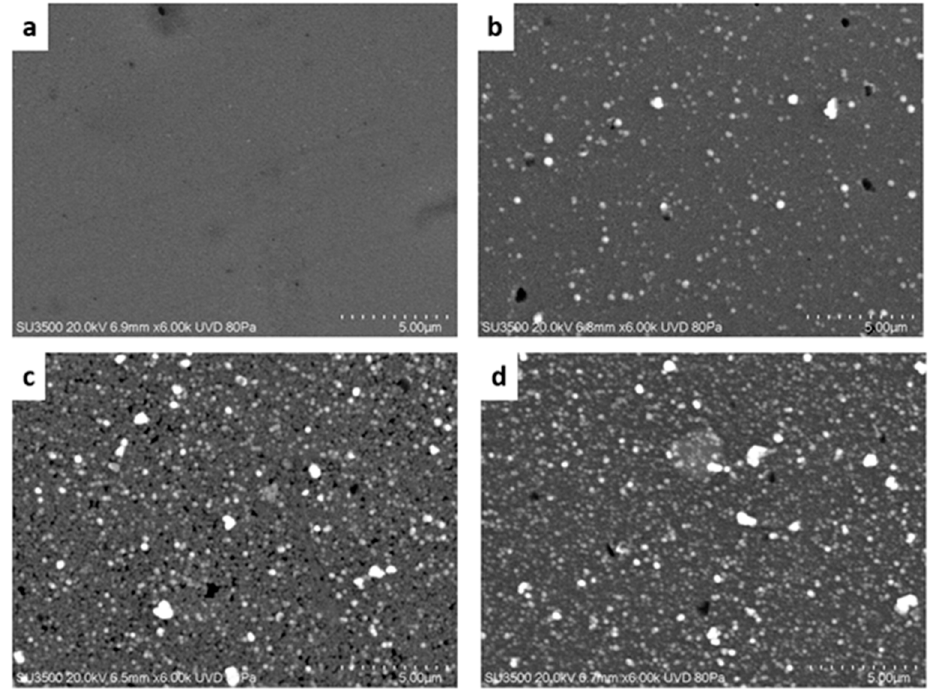
Figure 2. ( a – d ) SEM micrographs of the thin fi lms grown at R = [Al 3+ ]/[Cd 2+ ] = 0.00, 0.30, 0.40, 0.50 ratio. An increase in the number of surface grains was observed with higher aluminum